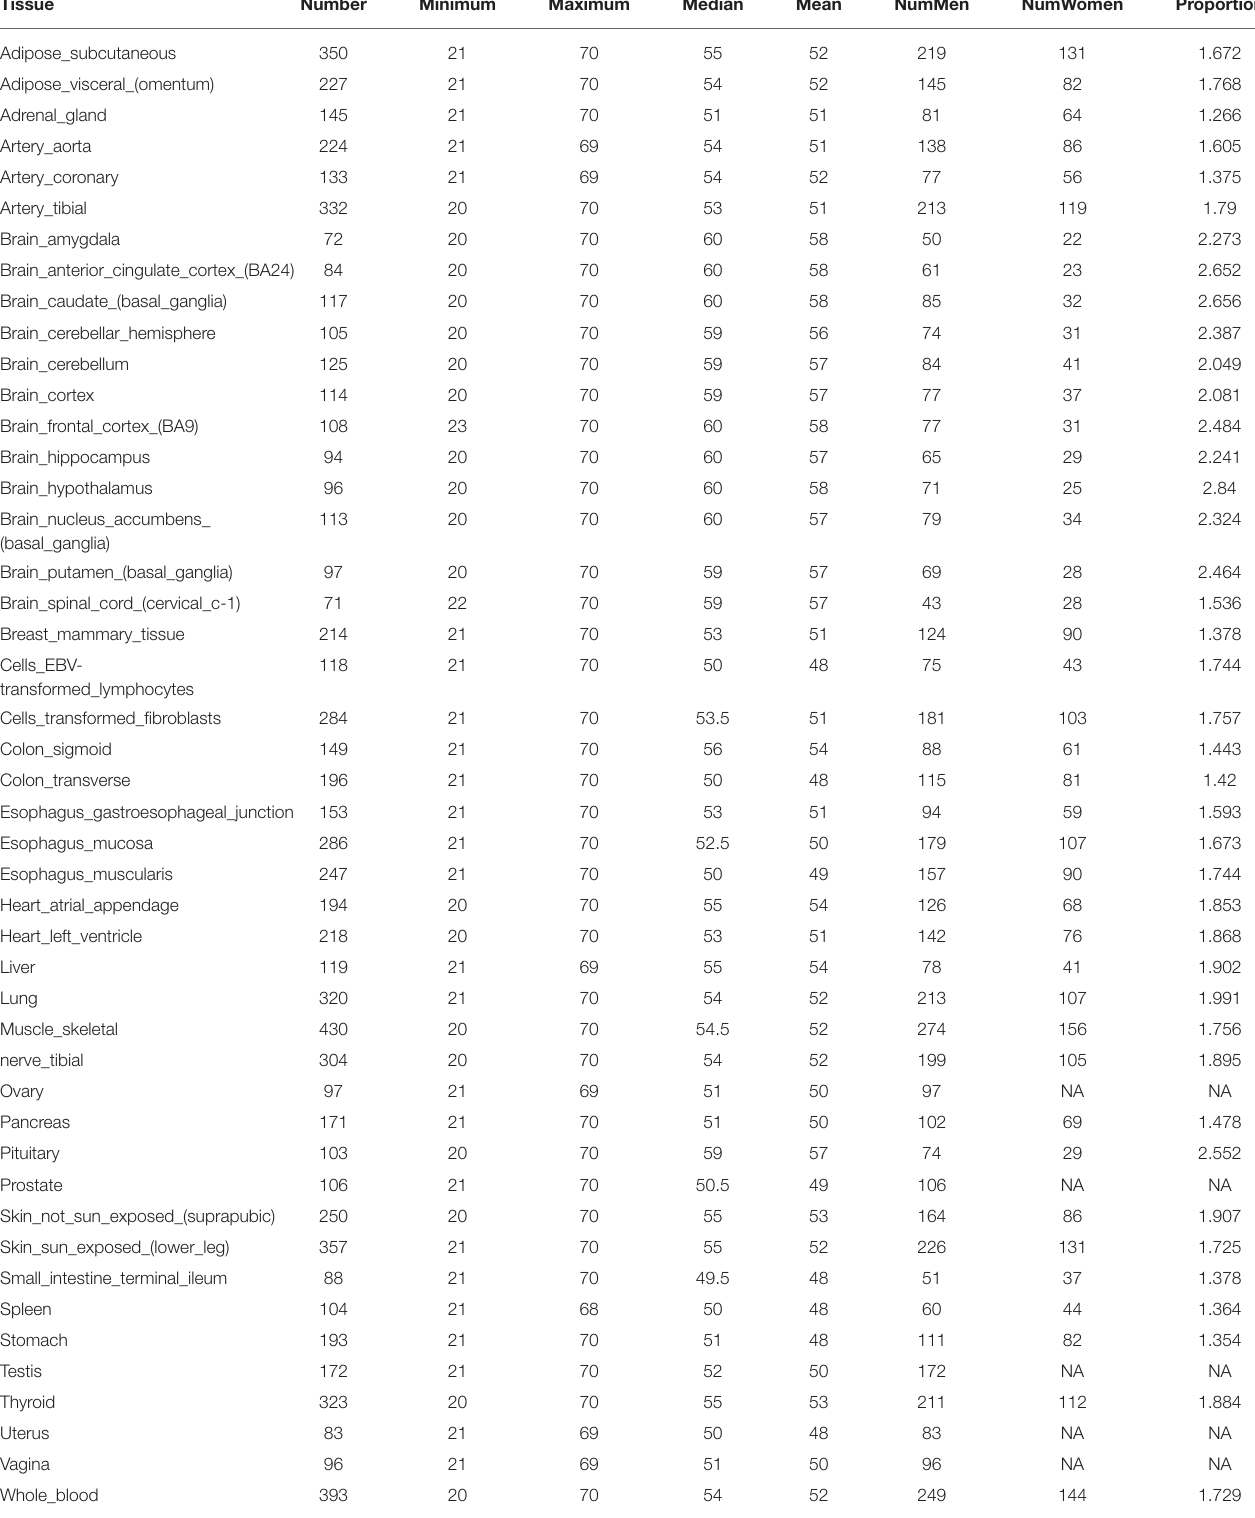
TABLE 1 | Sample Information of 46 tissues in